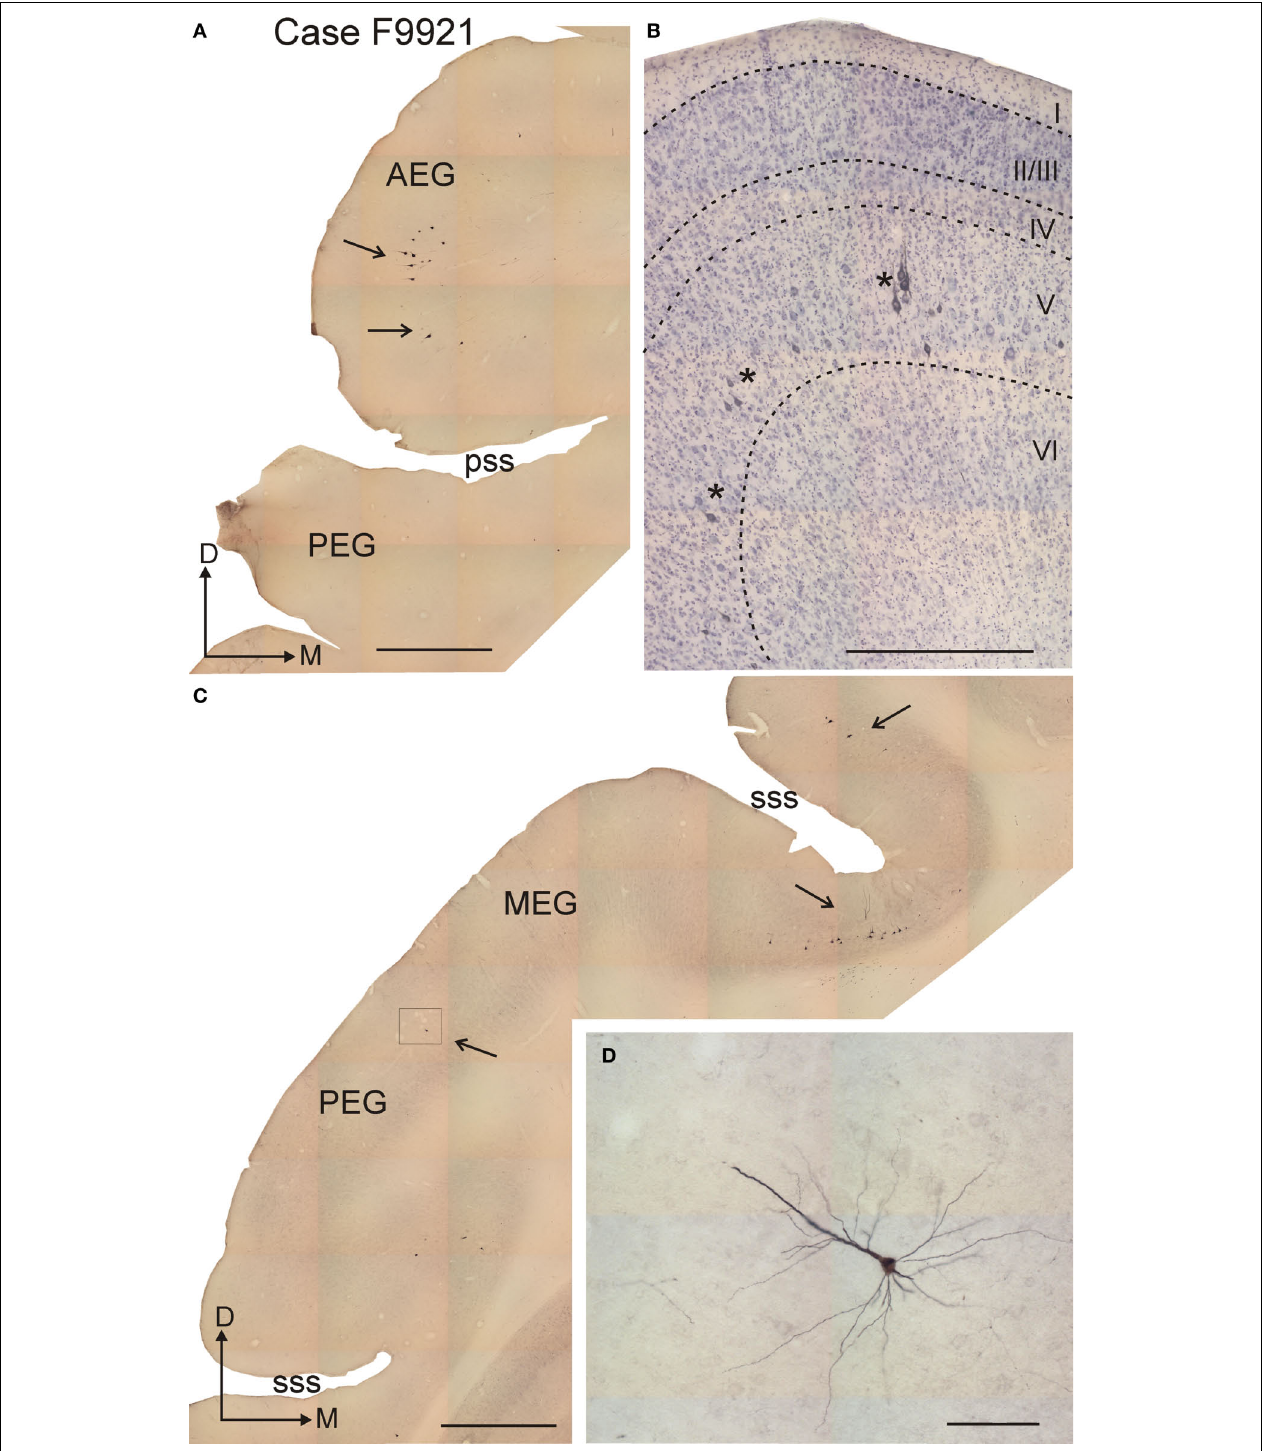
Nissl-counter-stained section at the level of the AEG; sets of two to three labeled neurons can be observed in layer V (asterisks). (D) Higher-magnifi cation photomicrograph showing the pyramidal morphology of a labeled neuron in layer V, whose thick apical dendrite runs orthogonal to the cortical layers. This photomicrograph was taken at the location shown by the frame in (C) . Calibration bars are 1 mm in (A) and (C) , 0.5 mm in (B) and 0.1 mm in (D)